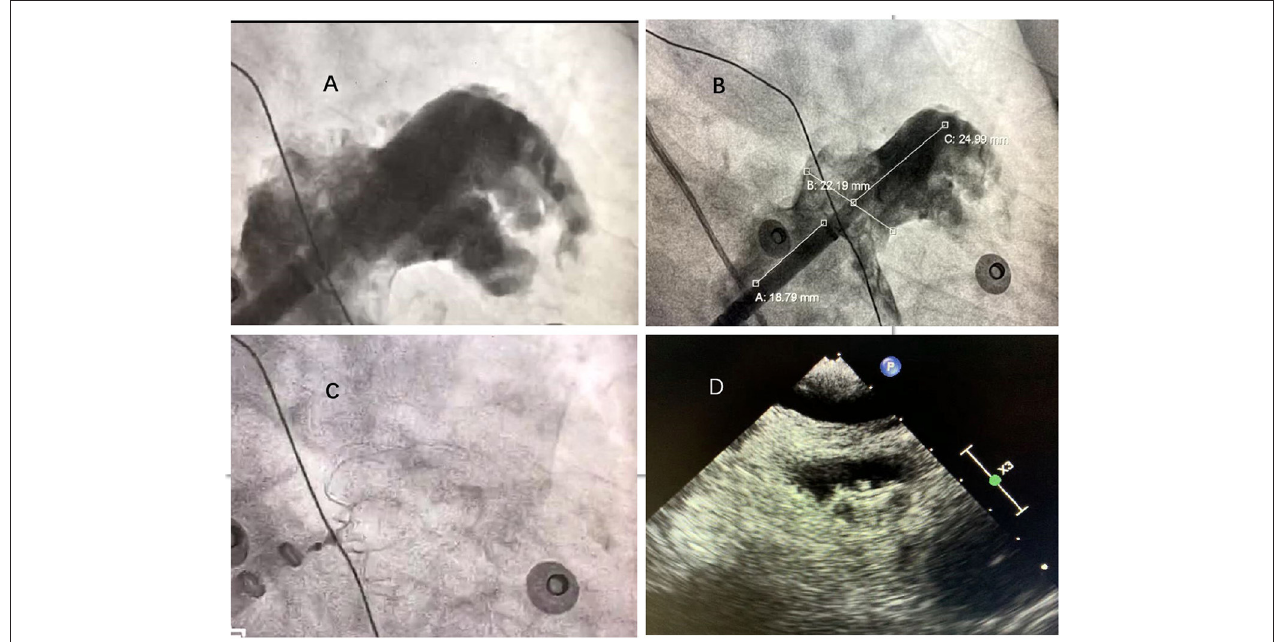
FIGURE 2 | Left atrial appendage closure with WATCHMAN device. (A) Left atrial appendage angiograph. (B) Ostial width and depth of LAA measured after angiograph. (C) Fluoroscopic view after delivery of the WATCHMAN device in the proper position. (D) : Peri-device leakage and compression were detected by TEE